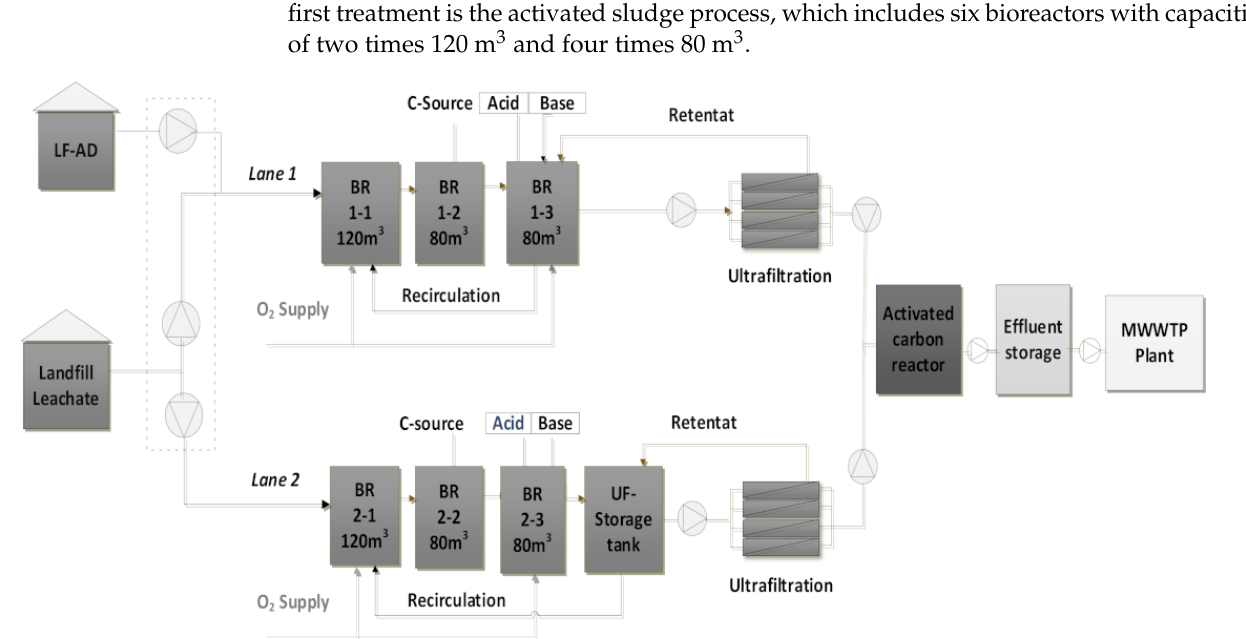
Figure 2. Flow diagram of the leachate treatment plant in